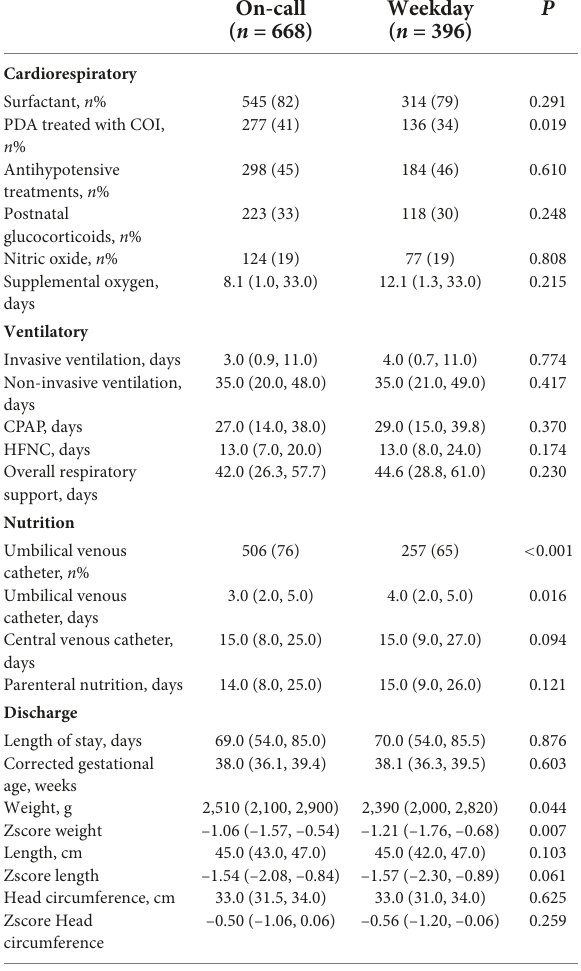
TABLE 2 Neonatal care according to the period of